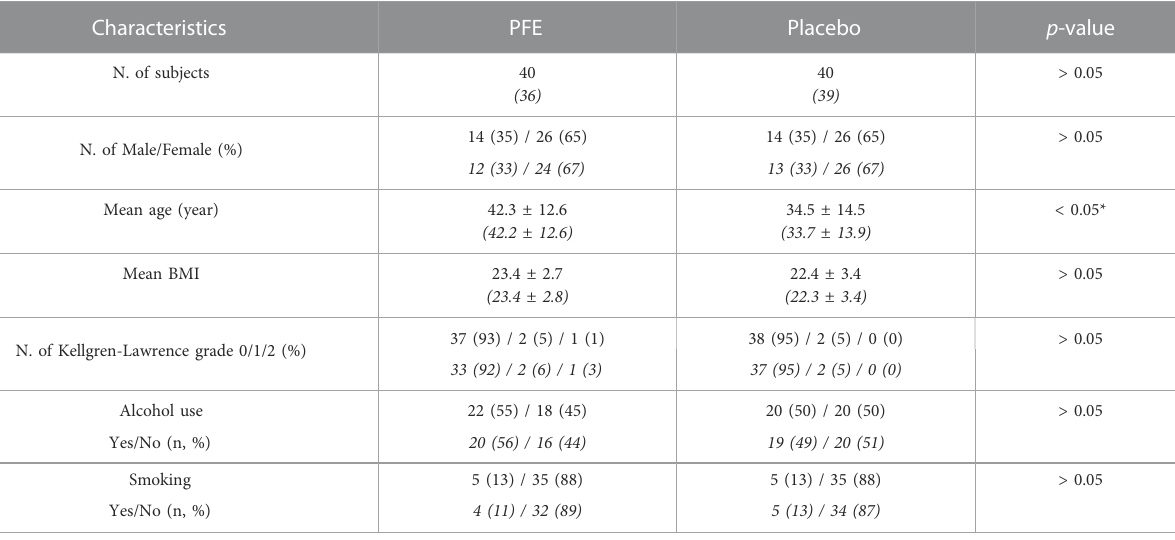
TABLE 1 Baseline characteristics of participants.